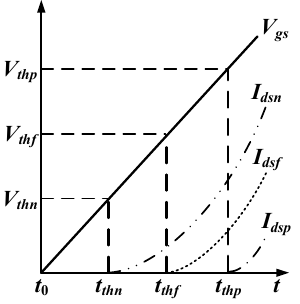
Figure 2. Waveforms of V gs and I ds in a turn-on state.